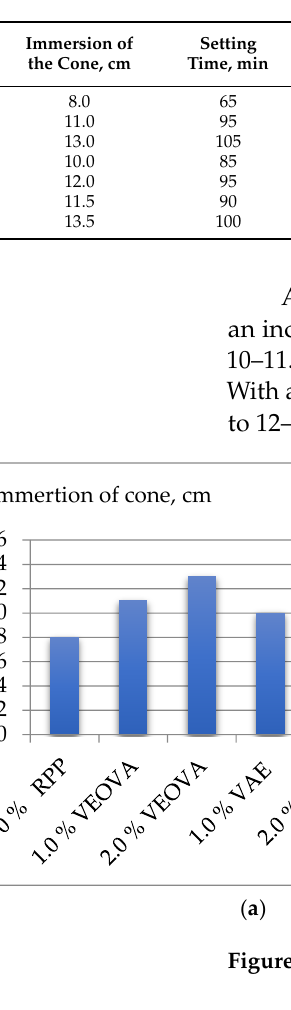
Figure 5. Structural strength in 30 min after mixing mixtures using RPP. Polymer powders have mixed effects on both compressive and splitting strengths at different curing times. According to the results obtained (Table 4 and Figure 5), the addition of polymers of all types significantly reduces the tensile splitting strength and compressive strength at the early stages of curing. However, when approaching 28 days of age, RPPs have a positive effect on the studied parameters.